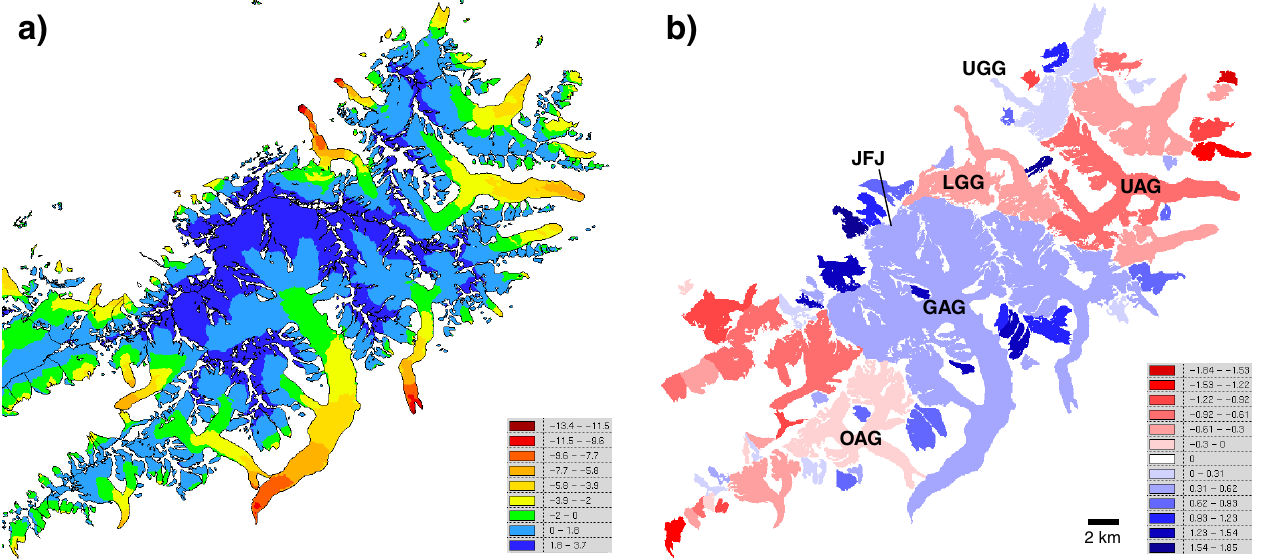
Fig. 3. (a) Mass balance distribution as obtained for the reference run using the DEM and outlines from 1850. (b) Resulting mean mass balance values for each glacier (colour coding in 1/2 standard deviations) for the same model run. Locations mentioned in the text are indicated (JFJ: Jungfraujoch, LGG/UGG: Lower/Upper Grindelwaldglacier, OAG: Oberaletschglacier, GAG: Great Aletschglacier, UAG: Unteraarglacier).